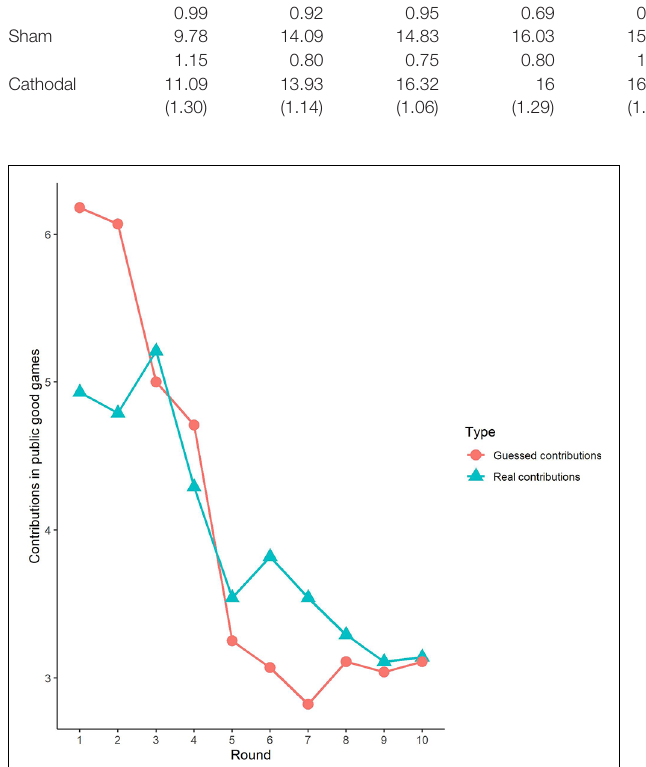
FIGURE 4 | Real contributions and guessed contributions by round in public bad games.